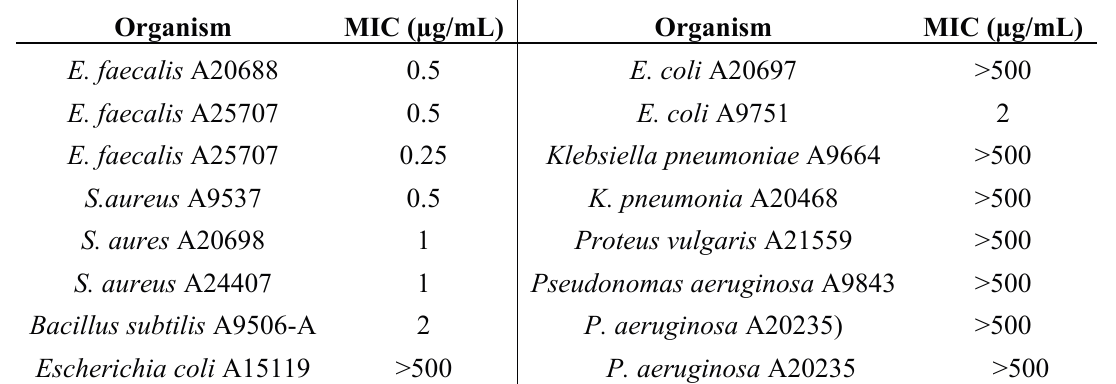
Table 5. Antimicrobial activities of 156 [71].